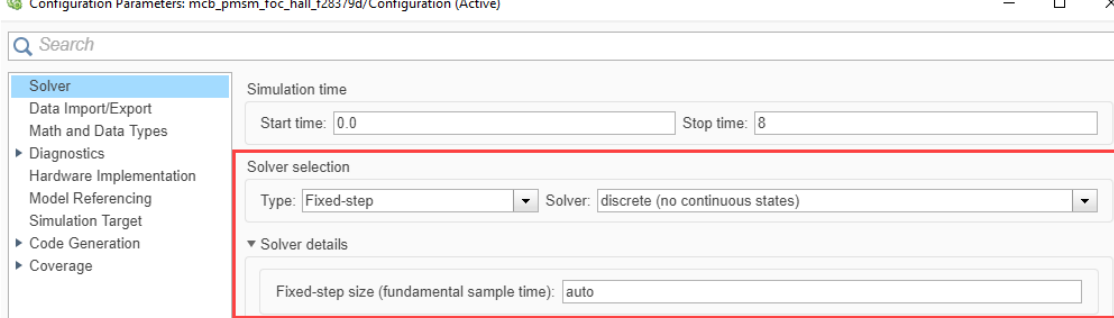
Figure 6. Configuration Parameters window.